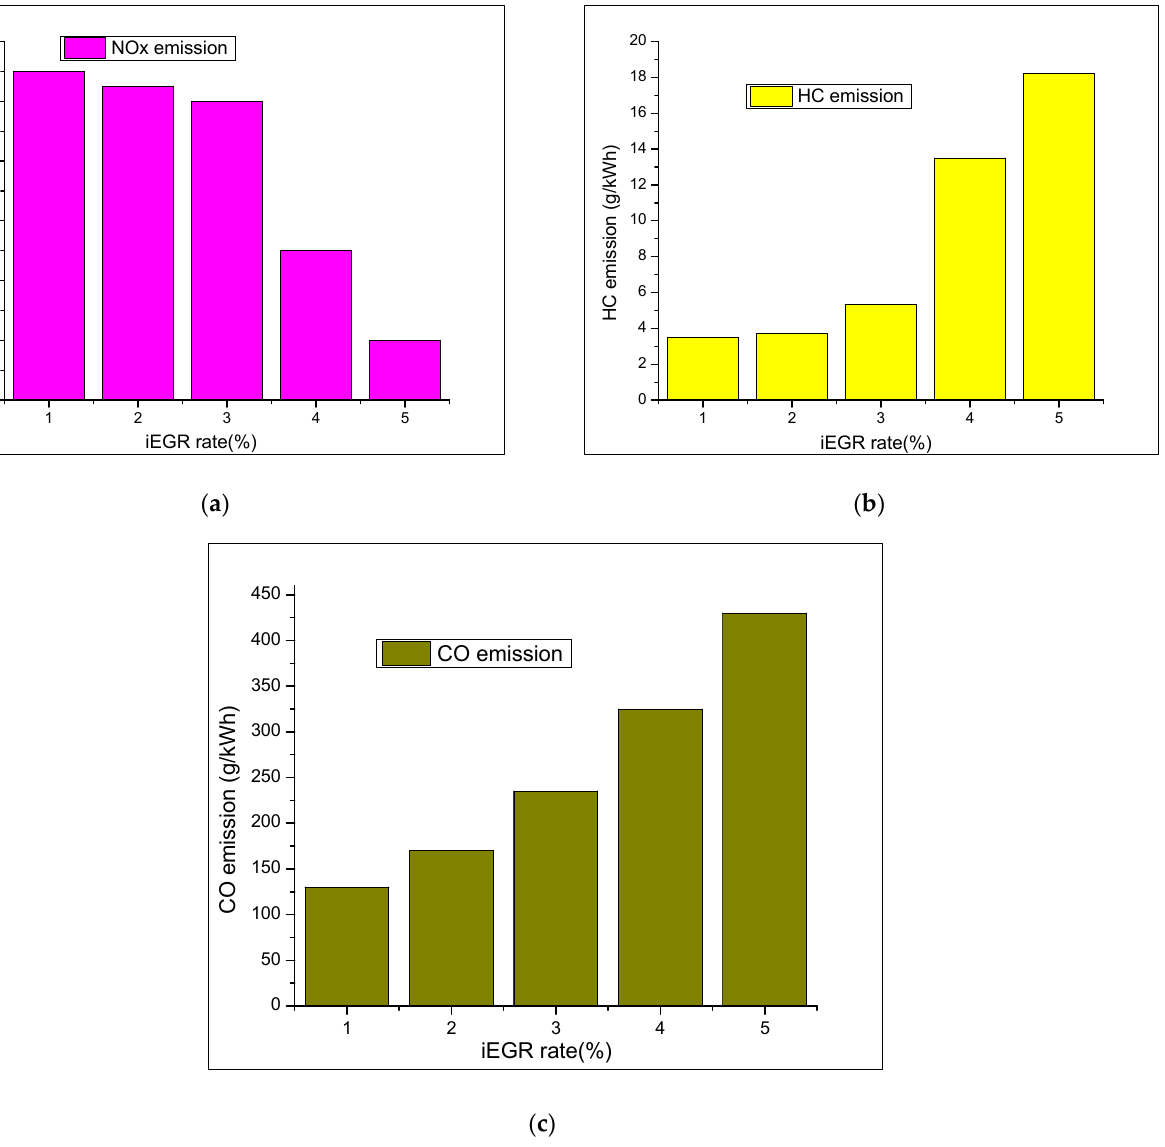
Figure 16. The effect of iEGR on egine emission versus iEGR [88]: ( a ) NOx emission; ( b ) HC emission; ( c ) CO emission.